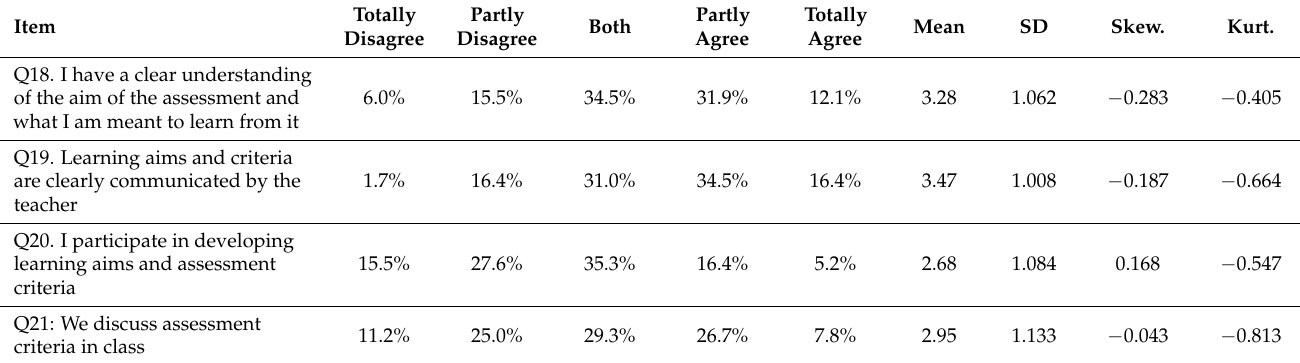
Table 6. Students’ understanding and involvement in developing learning goals and assessment